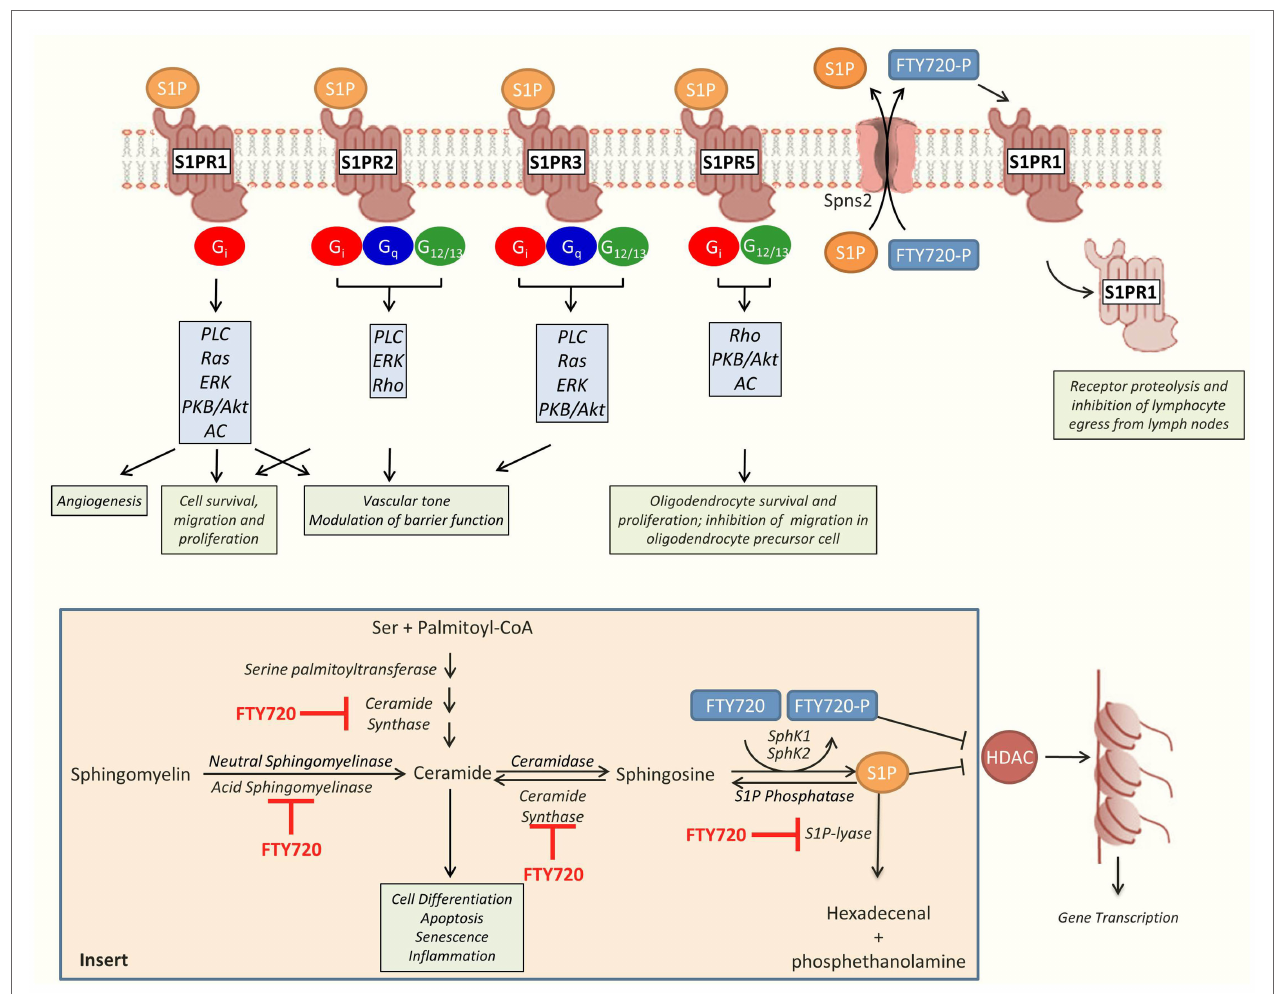
FiGUre 1 | overview of sphingosine-1-phosphate (s1p) and fingolimod (Fty720) effects . S1P signals through five different G protein-coupled cell surface receptors (S1PR 1-5). S1PR1–3 are ubiquitously expressed throughout the body. In comparison, S1PR4 is predominantly expressed in the immune system and S1PR5 in the central nervous system (CNS) and the spleen. These receptors are associated with different profiles of G α subunits, including G i , G q , and G 12/13 . The profile of S1PR and G α subunit expression enable cells to activate different downstream signaling pathways and to orchestrate complex responses in response to single agonist. The activated form of FTY720, FTY720-phosphate (FTY720-P), is a partial agonist of all the S1PRs, with the exception of S1PR2. Downstream, S1PRs regulate oxidative-stress-induced cell survival, endothelial barrier function, leukocyte migration and taxis, and oligodendrocyte survival and proliferation in the CNS (26, 30, 31). In the presence of FTY720-P, S1PR1 is downregulated from the cell surface impeding the egress of lymphocytes from lymph organs and causing lymphopenia (32). S1P and FTY720-P also regulate gene transcription through non-receptor-related epigenetic mechanisms related to the inhibition of histone deacetylases (HDAC). Insert : metabolism of sphingolipids (33). Ceramide, a central hub in the metabolism of sphingolipids, has been associated with cell death, quiescence, and differentiation. It can be generated by the breakdown of sphingomyelin by the acid or neutral sphingomyelinases, or synthesized de novo from serine and palmitoyl-CoA by serine-palmitoyl transferase and ceramide synthase. Ceramide can be metabolized into sphingosine which is then phosphorylated into S1P by the sphingosine-kinase 1 (SphK1) or 2 (SphK2). S1P is broken down into hexadecenal and phosphoethanolamine by the S1P-lyase. FTY720 is phosphorylated primarily by SphK2. Both S1P and FTY720-P are transported to the extracellular space by the membrane transporter Spns2 (34). In addition to its effect on cell membrane receptors and HDAC, FTY720 also inhibits several key enzymes involved in the metabolism of sphingolipids, including ceramide synthase, acid sphingomyelinase, and S1P-lyase. AC, adenylate cyclase; ERK, extracellular signal-regulated kinase; PKB, protein kinase B; PLC, phospholipase